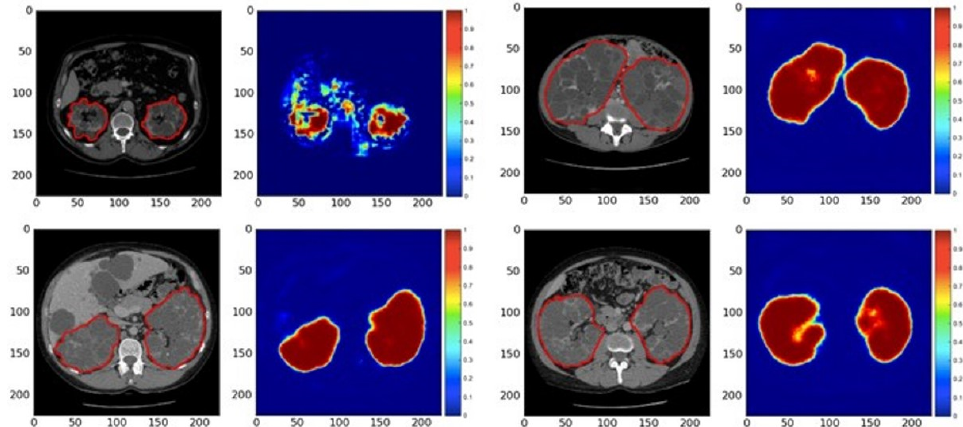
Figure 10. ADPKD Kidney CNN assumptions. Four representations (red contour) of ADPKD kidneys from multiple patient accomplishments. The subsequent CNN-produced graphs are included in pseudo-colors. Reproduced with permission from [178].